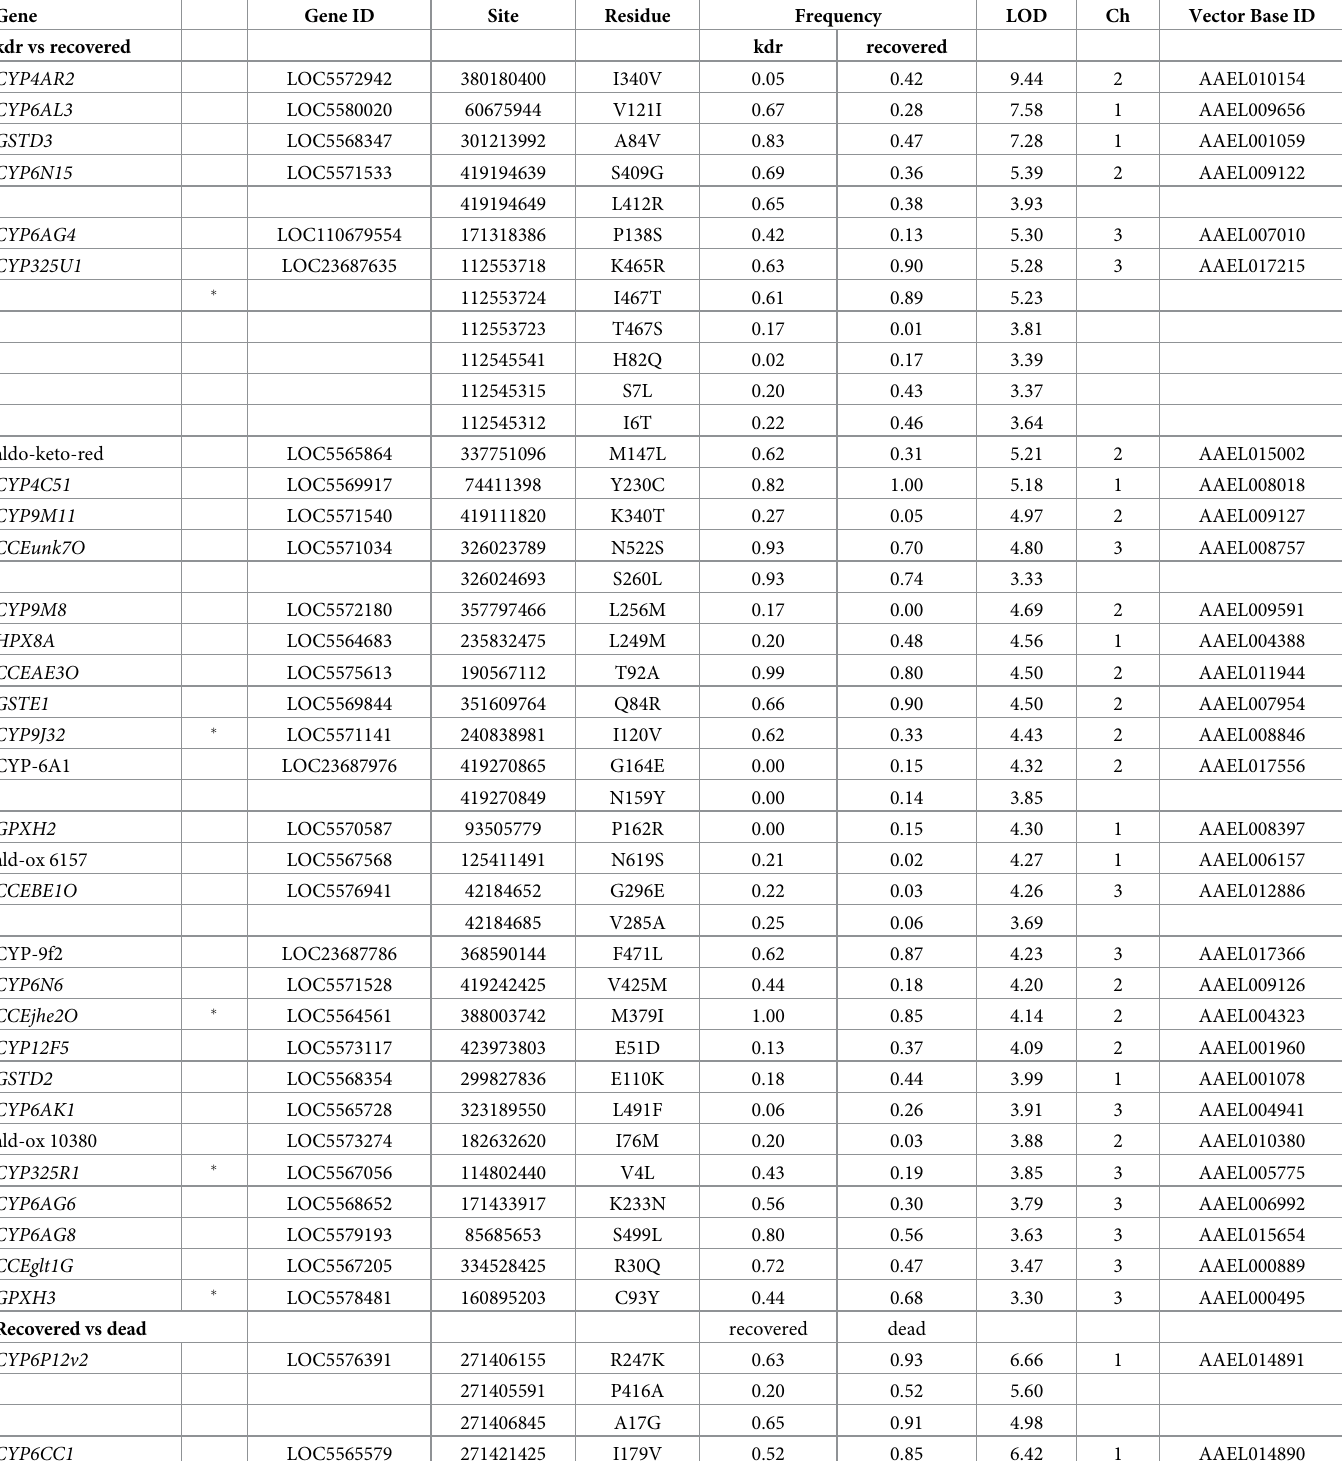
Table 4. Nonsynonymous SNPs in detoxification genes associated with kdr , recovered, or dead Aedes aegypti exposed to permethrin. The gene identification, site, amino acid residue (based in the AaegL5 genome assembly), frequency of alternative nucleotide for each phenotype, the associated LOD values, chromosome (Ch) and vec- tor base identification (www.vectorbase.org) are shown. � indicates SNPs occurring in two or more pairwise comparisons.